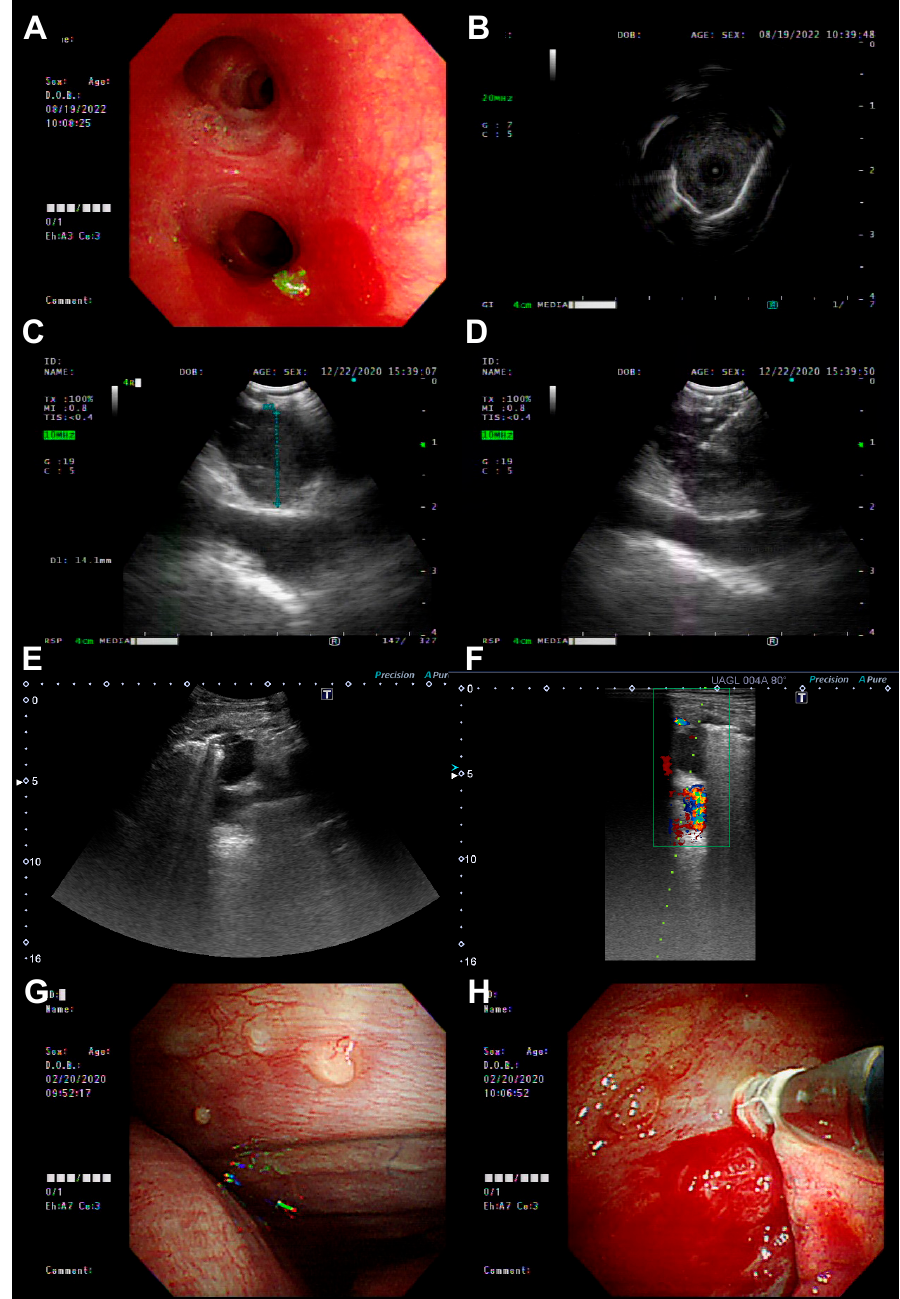
Figure 1. The biopsy procedures included IP methods: ( A , B ) Bronchoscopy with radial probe ‐ EBUS (R ‐ EBUS); ( C , D ) EBUS ‐ TBNA; ( E , F ) sono ‐ guided biopsy; and ( G , H ) medical pleuroscopy.